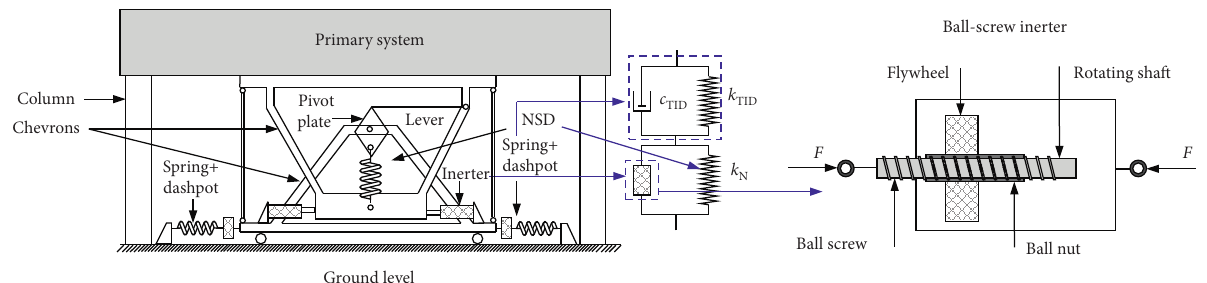
Figure 2: Schematic representation for the physical realization of